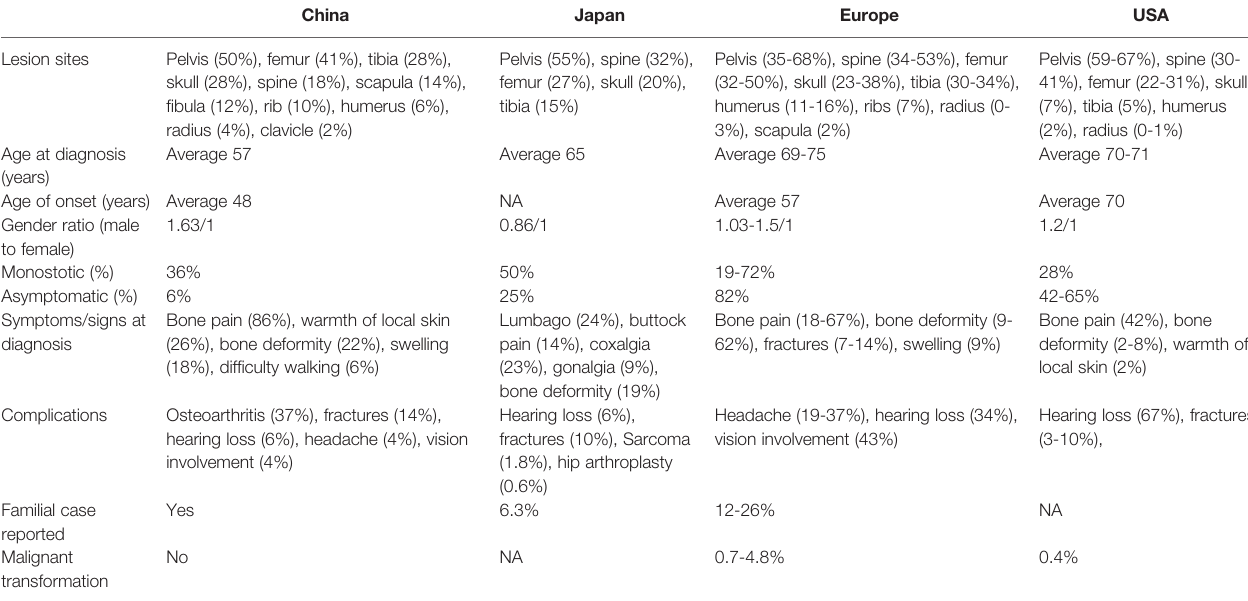
TABLE 8 | Comparison of clinical features between PDB observed in China and that of occurred in Western countries (2, 6, 16, 47 – 52). China